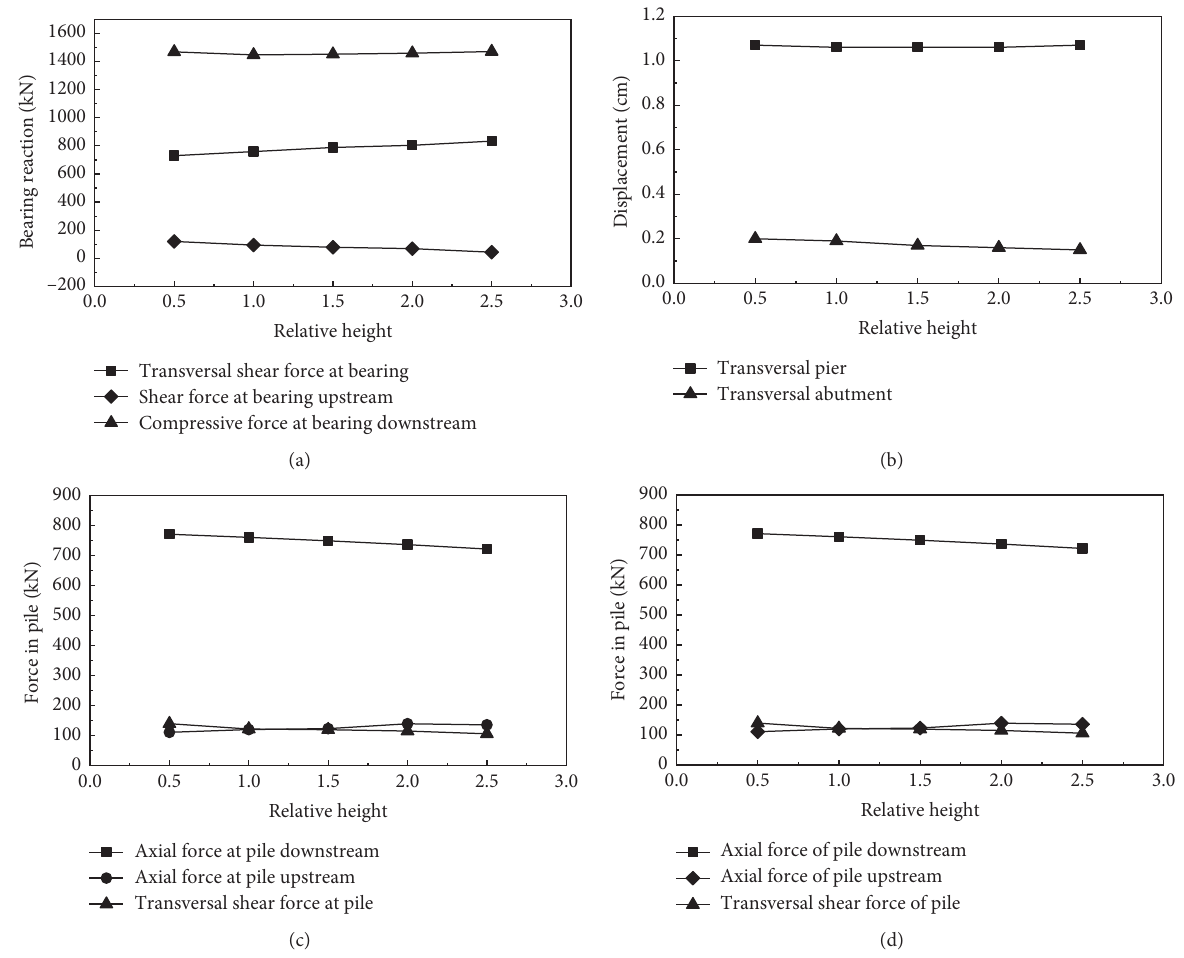
Figure 24: Variation of inner forces of structure and deflections with H . (a) Vertical force in seats. (b) Displacement. (c) Inner force in piers. (d) Inner force in piles.